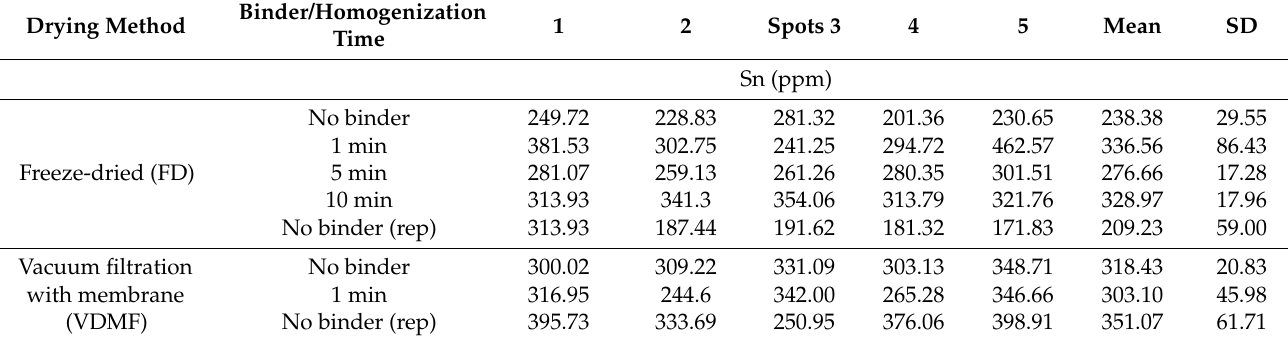
Table 6. Summary of the Sn concentrations (ppm) of the Penouta ore pellets obtained by LA-ICP- MS spot analysis following pellet production using different drying techniques. The values are based on data normalized to SiO 2 as an internal standard. SD = standard deviation; rep = repeated analytical